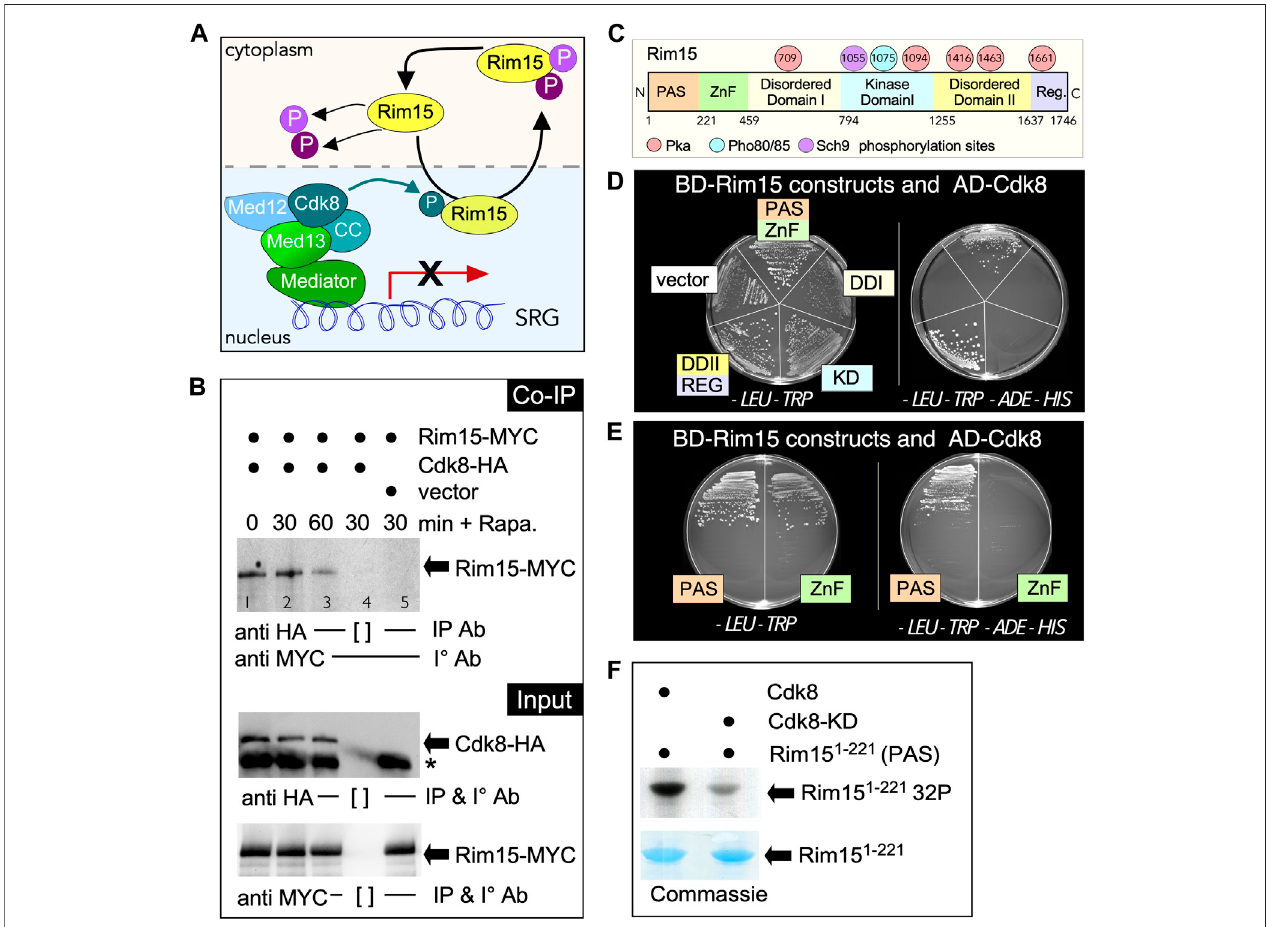
FIGURE 4 | Cdk8 directly phosphorylates Rim15. (A) Outline of the potential role of Cdk8 kinase in regulating Rim15. (B) Co-immunoprecipitation analysis of Rim15-MYC and Cdk8-HA. Whole cell lysates from wild type cells harboring Rim15-MYC (pVW904) and Cdk8-3HA (pUM504), lanes 1 – 4, or a vector control, lane 5, were immunoprecipitated with the antibodies shown before and after treatment with 200 ng/ml rapamycin. [ ] represents no antibody control. For input controls, Cdk8-HA and Rim15-MYC were immunoprecipitated from whole cell lysates with the indicated antibodies. (C) Map of Rim15 depicting different structural regions and known PKA, Pho80/85 and Sch9 phosphorylation sites. (D,E) Rim15-Cdk8 Y2H analysis. Y2H Gold cells (RSY 2000) harboring Gal4-BD-Cdk8 and the indicated Gal4-AD-Rim15 subclone or empty vector control were streaked on medium selecting for plasmid maintenance (left) or induction of the ADE2 and HIS3 reporter genes (right) by Y2H interaction. (F) Kinase assay of the Rim15 PAS domain (amino acids 1 – 221) by Cdk8 and its kinase dead (D290A) variant. Cdk8-9myc was immunoprecipitated from YC17 and YC7 respectively and used to phosphorylate Rim15 1 − 221 puri fi ed from E. coli . See methods section for more